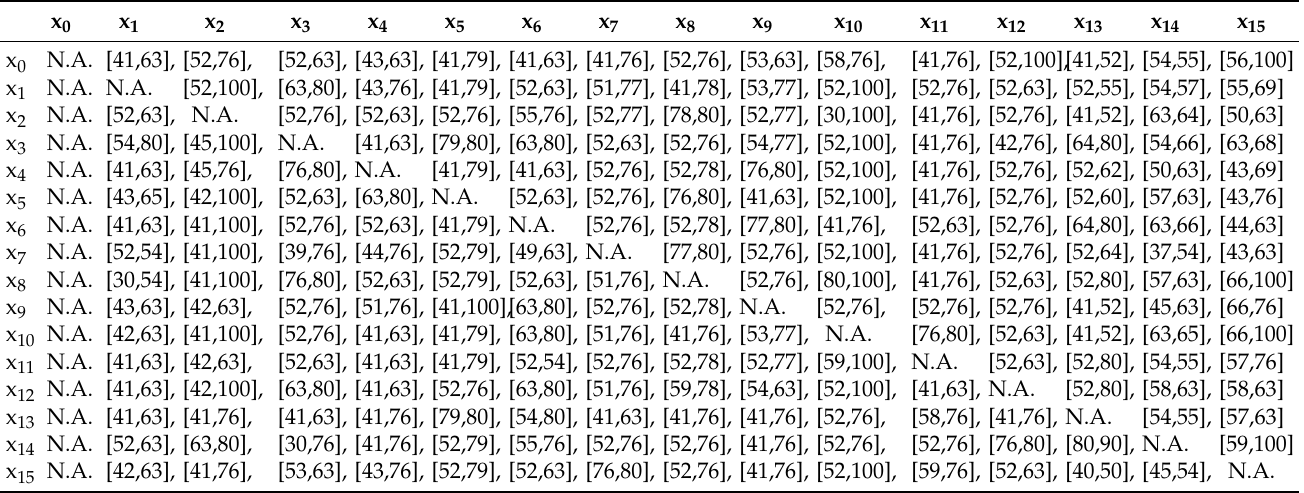
Table A2. Fuzzy costs for the objective O 2